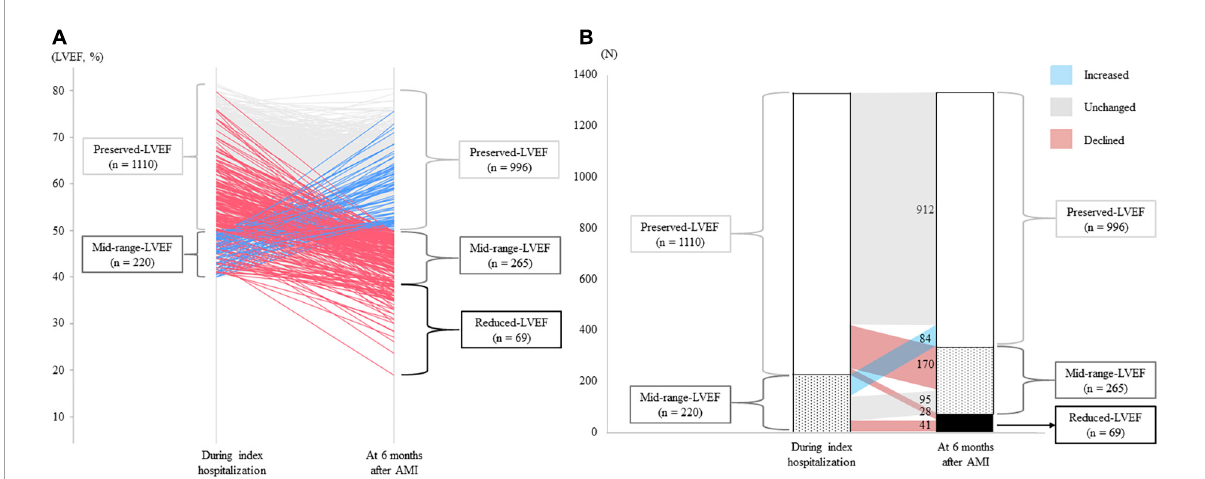
FIGURE2 LVEF trajectories from index hospitalization for AMI to 6 months post-AMI. (A) Individual trajectories of LVEF over the 6 months after AMI. Blue, gray, red lines indicate patients with increased, unchanged, and declined LVEF, respectively. (B) Changes in LVEF categories. The numbers in the figure indicate the number of patients whose LVEF category changed or did not change 6 months after AMI. AMI, acute myocardial infarction; LVEF, left ventricular ejection